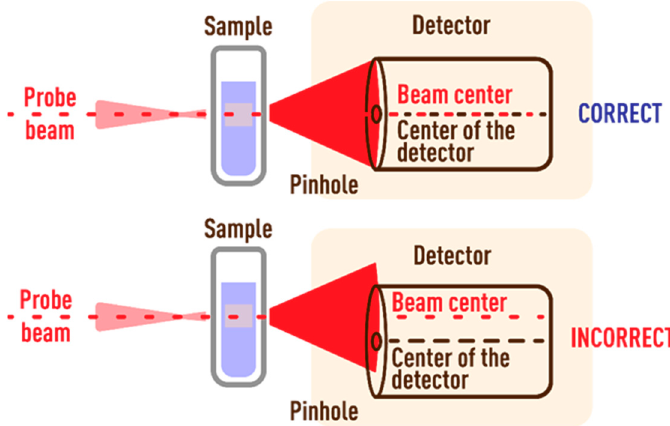
Figure 11. Scheme of beam incidence on the detector pinhole.